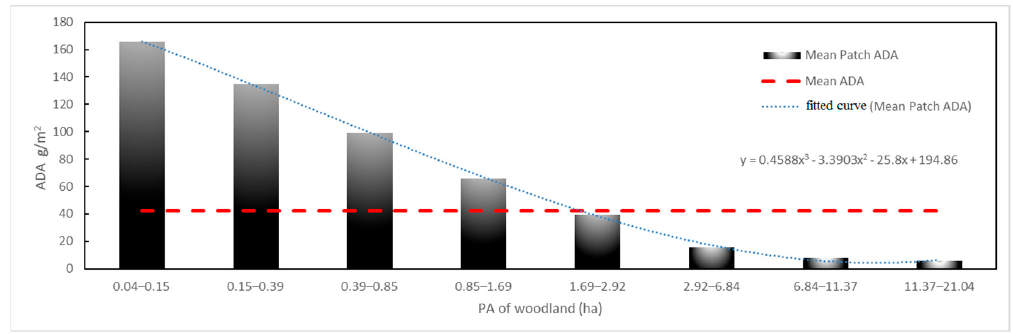
Figure 11. The amount of dust absorption (ADA) by patch area (PA) of woodland.